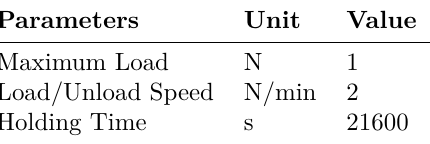
Table 2. Indentation